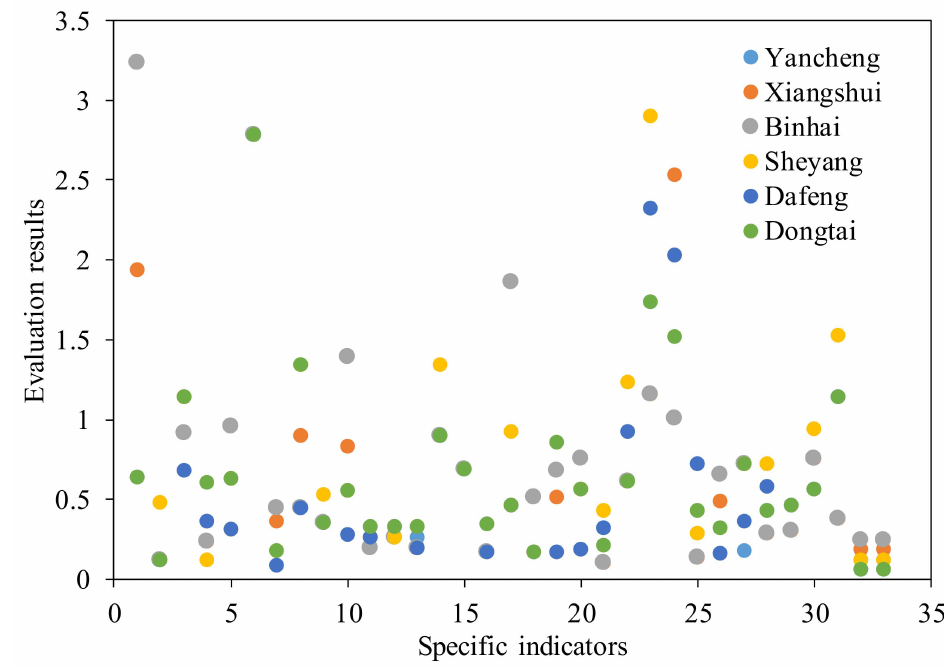
Figure 5. Ecosystem stability index layer (D) evaluation